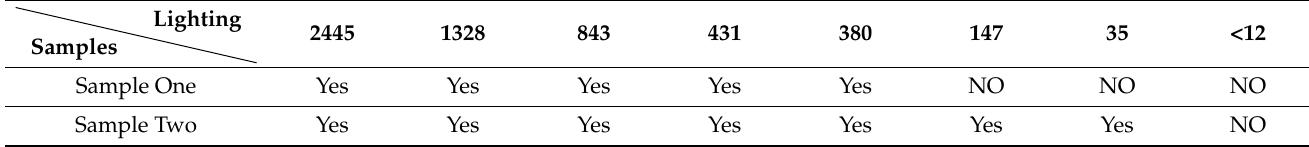
Table 2. Various Lighting Test Samples